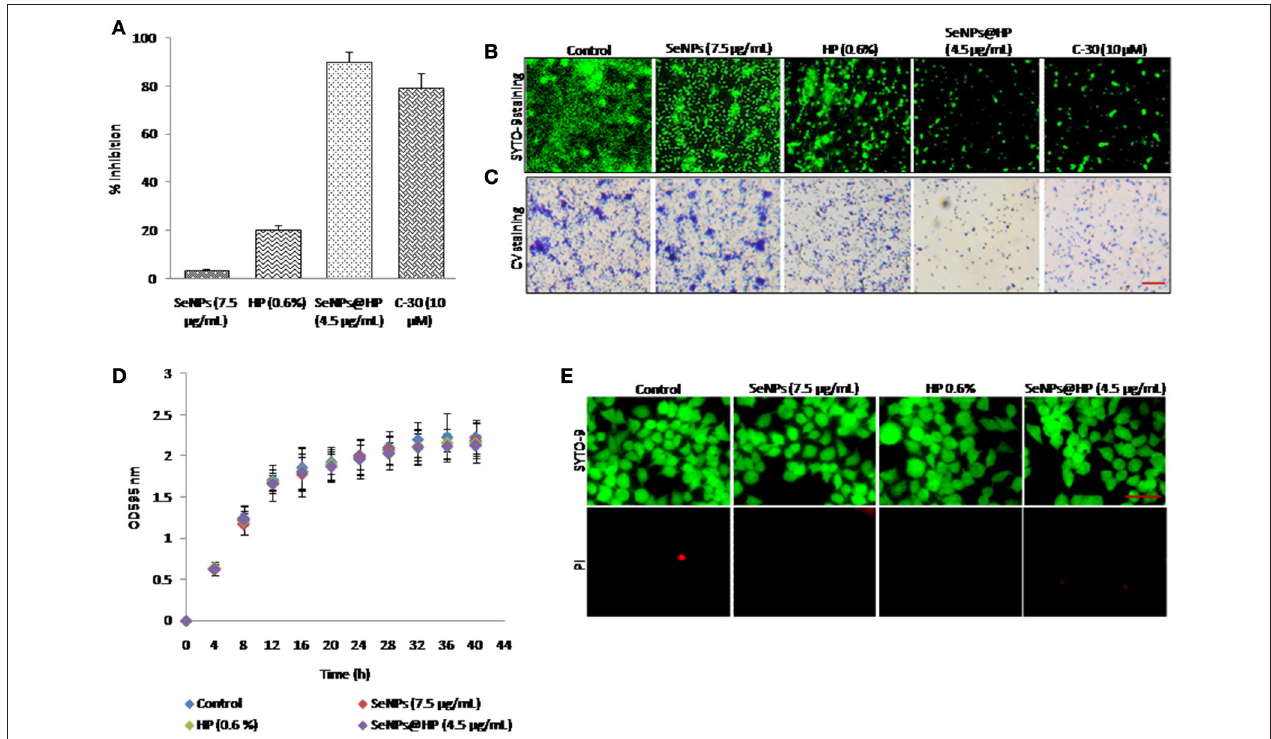
FIGURE 4 | Anti-biofilm potential of SeNPs@HP. (A) Inhibitory action of SeNPs (7.5 µ g/mL), HP (0.6%), SeNPs@HP (4.5 µ g/mL), and furanone C-30 (10 µ M) on P. aeruginosa PAO1 biofilm formation was determined using CV staining assay for 24 h in MTP. Error bars indicate the standard deviations of 8 measurements. (B) Fluorescent and (C) light microscopic images of P. aeruginosa PAO1 biofilms developed on cover glass slides in the presence of SeNPs (7.5 µ g/mL), HP (0.6%), SeNPs@HP (4.5 µ g/mL), and furanone C-30 (10 µ M) and DW treated control. The biofilm cells were stained with SYTO-9 and CV and analyzed observed green fluorescence and phase contrast lights, respectively. The DW was used to maintain untreated control. The scale bar: 5 µ m. (D) Growth curve analysis of P. aeruginosa PAO1 in the presence of SeNPs (7.5 µ g/mL), HP (0.6%) and SeNPs@HP (4.5 µ g/mL) for 40 h in flask. Error bars indicate the standard deviations of three measurements. (E) Cytotoxic effect of SeNPs (7.5 µ g/mL), HP (0.6%) and SeNPs@HP (4.5 µ g/mL) on human lung epithelial cells for 24 h. The cells growing on cover slips were stained with SYTO-9 green for live cells and with PI red for dead cells and analyzed under a fluorescence microscope at 20x magnification. The